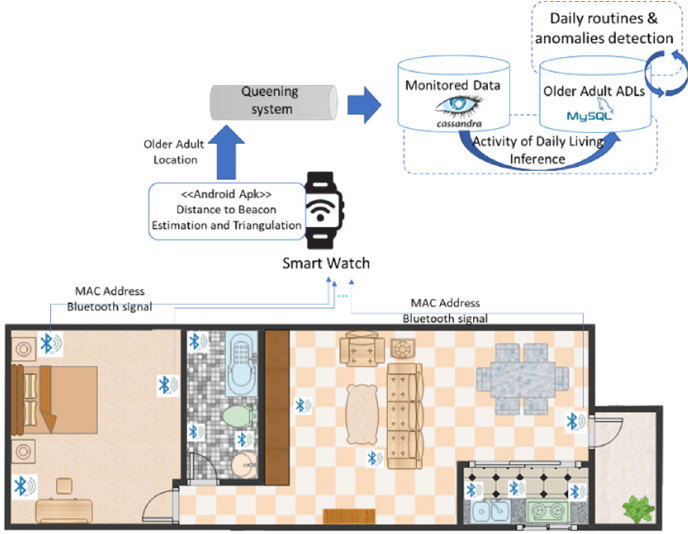
Figure 3. Experimental system for ADL monitoring. Table 1. Beacon’s